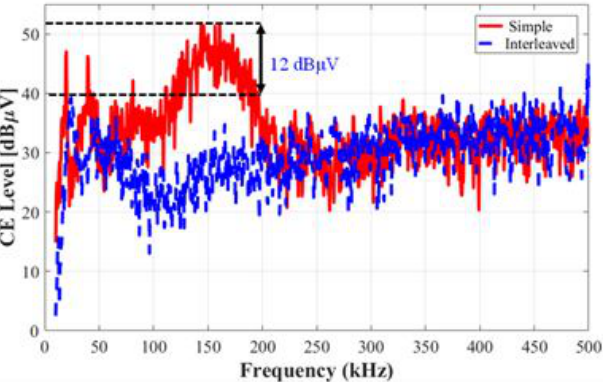
Figure 14. Comparison of the conducted emission results of the RCFMFD modulation schemes for simple and interleaved buck